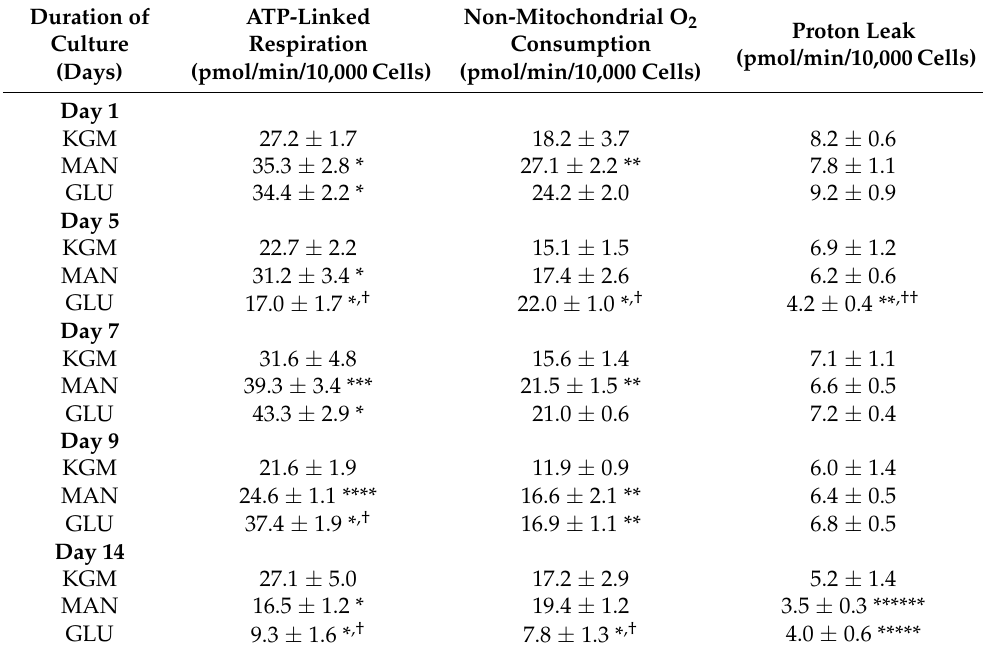
Table 1. Cellular oxygen consumption over